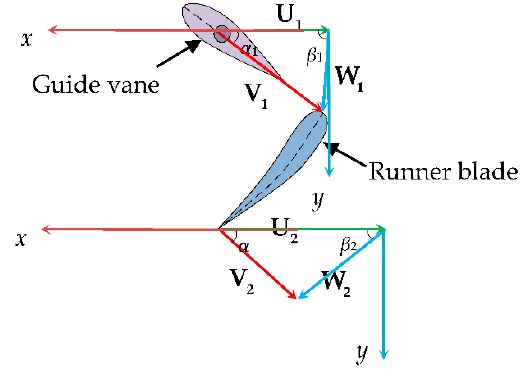
Figure 1. The velocity triangle in the blade inlet and outlet.